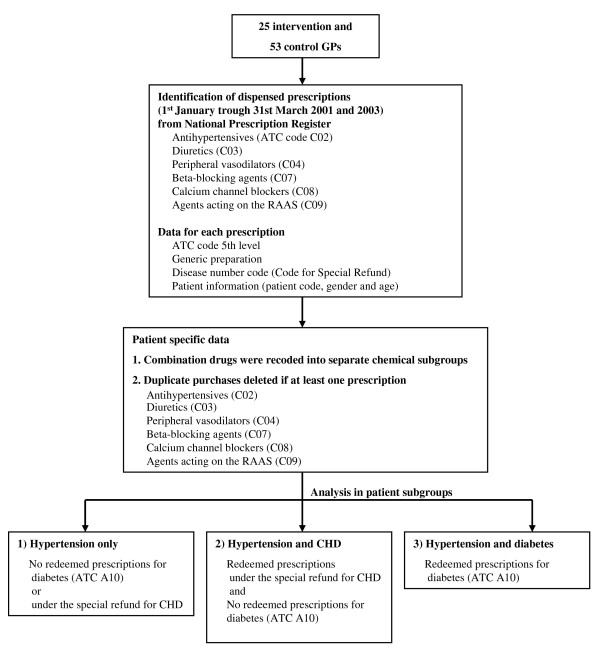
The conversion of the prescription data to represent each patient's drugs. Abbreviations: GP, general practitioner; ATC, Anatomical Therapeutic Chemical; RAAS, renin-angiotensin-aldosterone system; CHD, coronary heart disease.